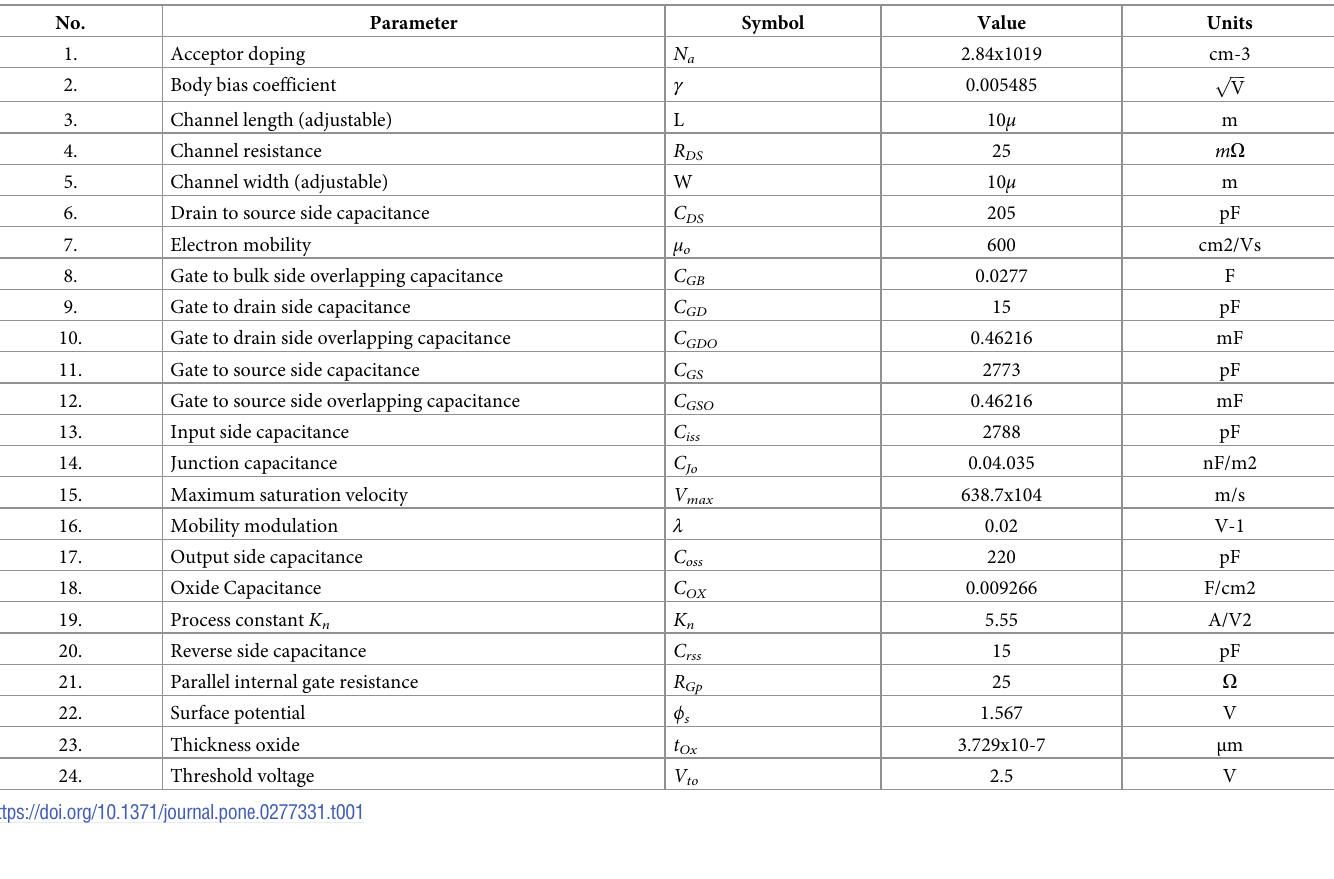
Table 1. Sic level 3 nmos model extracted